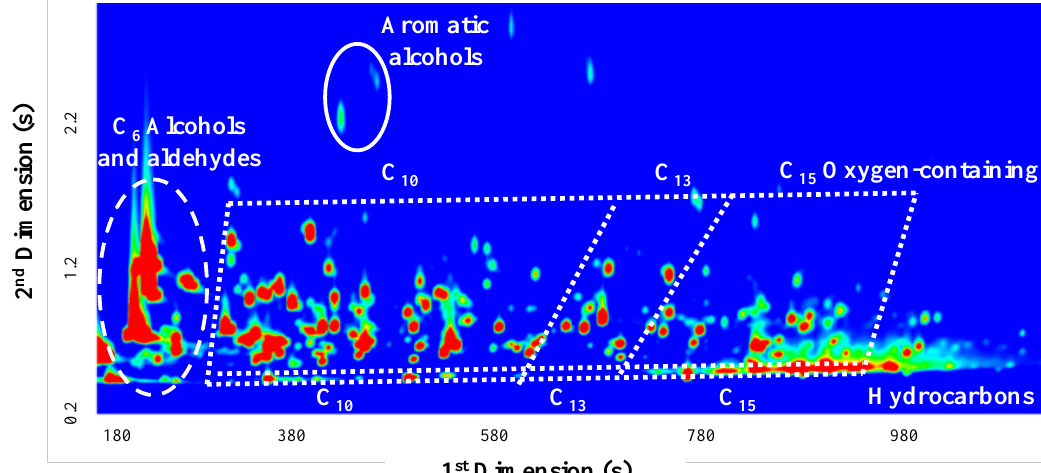
Figure 3. Blow-up of a GC × GC-ToFMS chromatogram contour plot obtained in full-scan mode for AR-VA2 grapes collected in 2010. The chromatographic spaces corresponding to C 6 alcohols and aldehydes, aromatic alcohols, mono (C 10 ) and sesquiterpenic (C 15 ) compounds, and C 13 norisoprenoids were highlighted.